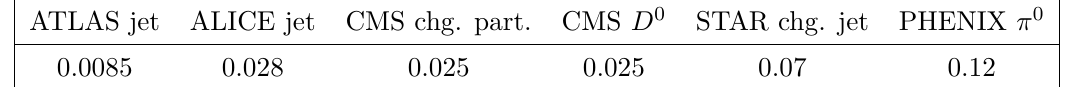
Table 2 . Normalization uncertainty level of different measurements in 0–10% Pb-Pb collision or 0–10% Au-Au collisions.